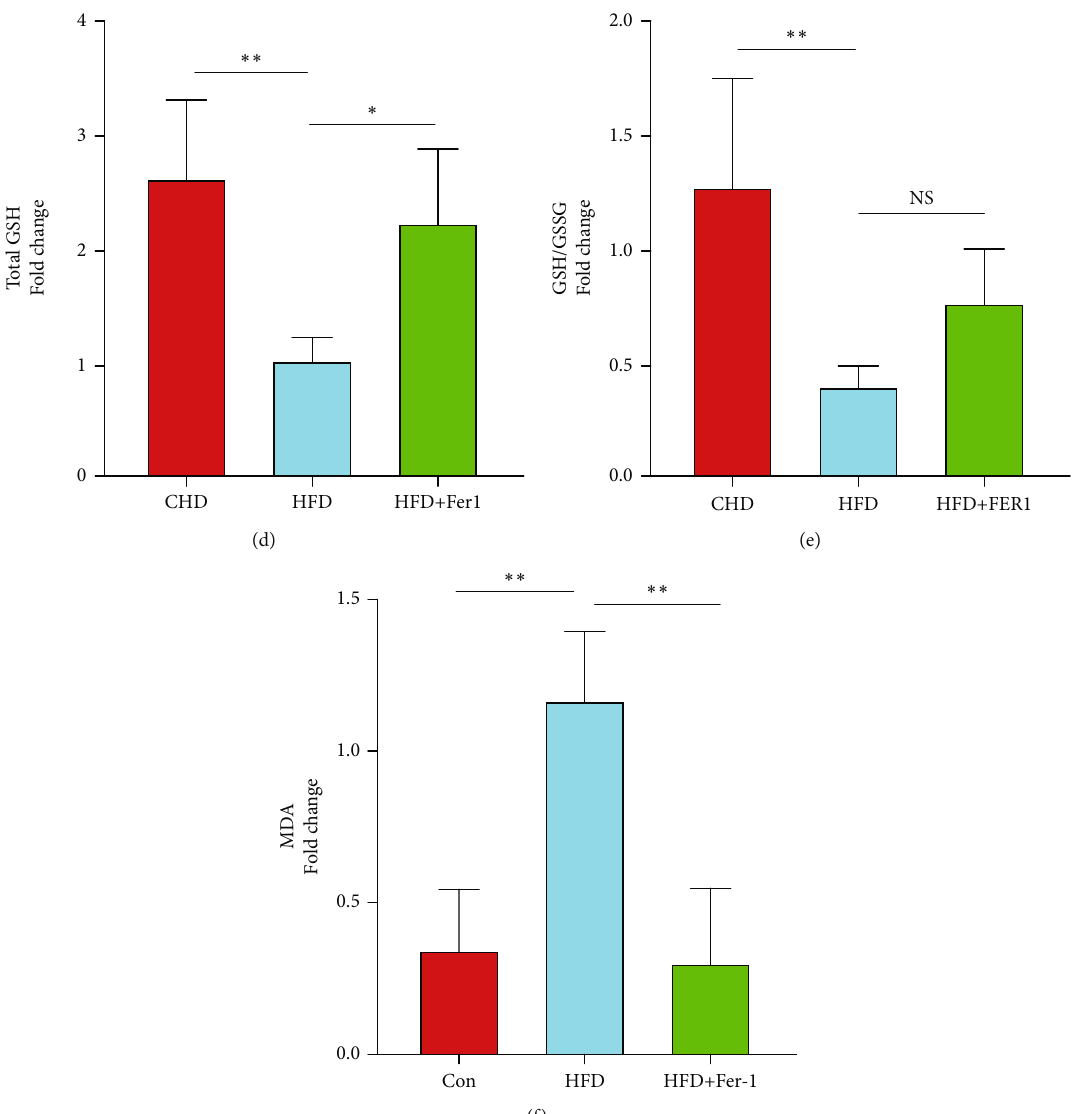
Figure 3: To demonstrate whether ferroptosis occurred in bone tissue of mice fed a high-fat diet, the expression of Gpx4 protein, a key protein for ferroptosis, in the femur of mice was examined using immuno fl uorescence staining. A signi fi cant decrease in the number of Gpx4 positive cells in the bone marrow of mice fed a high-fat diet was found (a), and after administration of a ferroptosis inhibitor, the number of Gpx4-positive cells increased signi fi cantly compared to the group fed a high-fat diet alone (a, b). Gpx4-positive cells in red and DAPI-stained nuclei in blue. n = 5/group , ∗ P < 0 : 05 , ∗∗ P < 0 : 01 . By measuring biochemical indicators of ferroptosis in the normal diet group, high-fat diet group, and high-fat diet plus ferroptosis inhibitor group, iron content (c), the total GSH content (d), GSH/GSSG ratio (e), and MDA content (f) in the femurs of mice were found to be n = 5/group , ∗ P < 0 : 05 , ∗∗ P < 0 : 01 ; NS indicates no statistical di ff